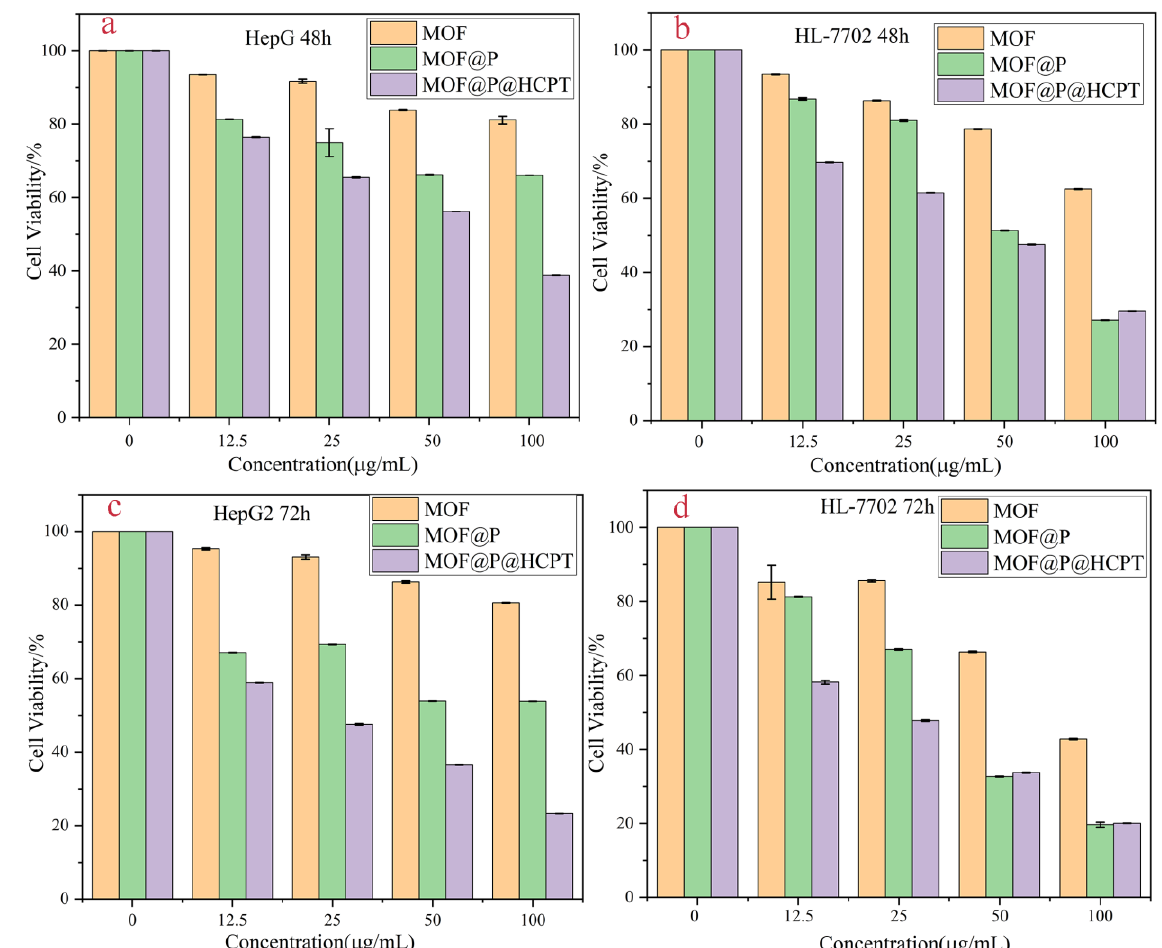
Figure 10. Cell viability of HepG2 cells and HL-7702 cells treated with MOF, MOF@P, and MOF@P@HCPT in different concentrations at 48 h ( a , b ) and 72 h ( c , d ).